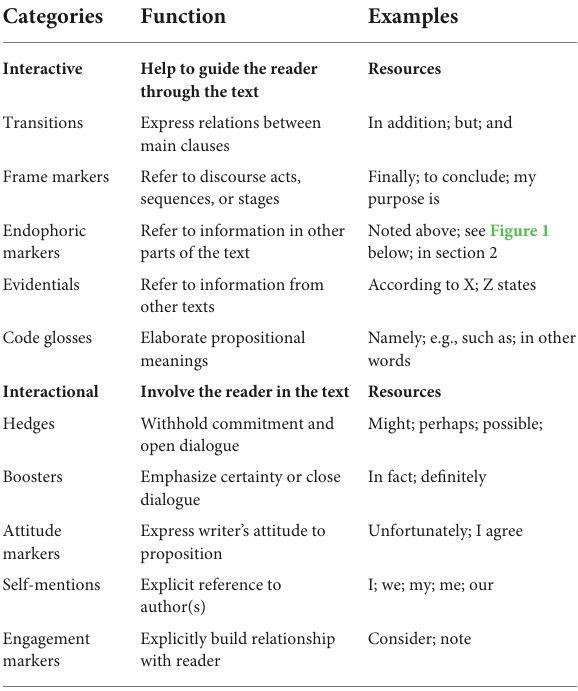
TABLE 1 Hyland’s (2005) interpersonal model of